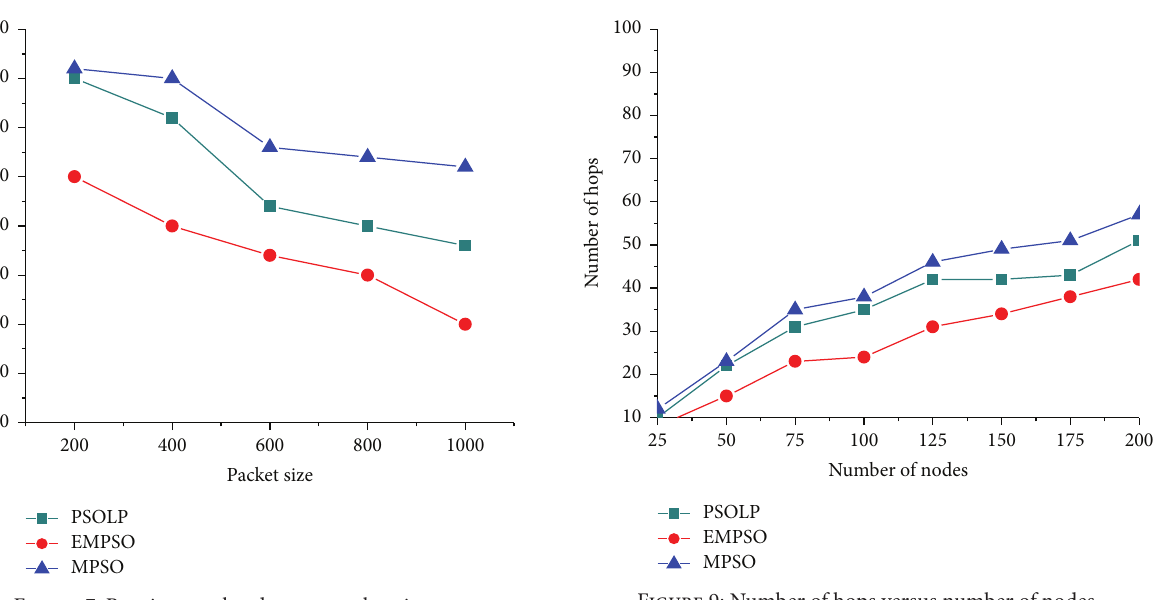
Figure 7: Routing overhead versus packet size.